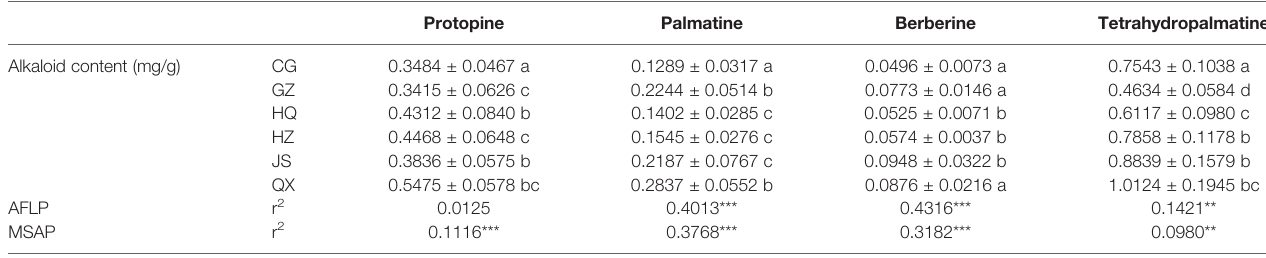
TABLE 3 | The contents of four alkaloids for 6 cultivated populations of Corydalis yanhusuo and results of correlating alkaloid variation to epigenetic and genetic